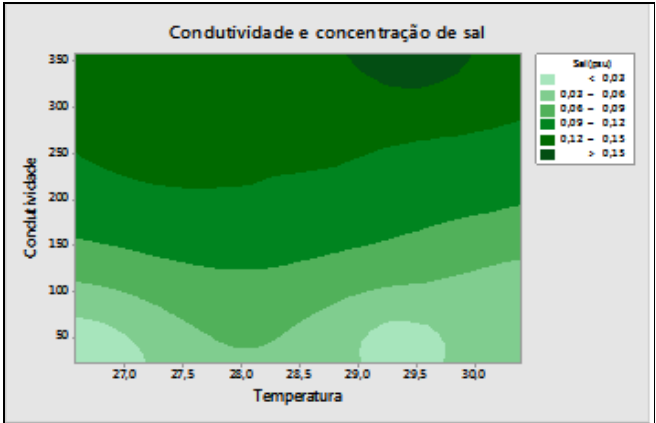
Figura 14: Concentração de sal das amostras. Fonte: Autores, (2018).